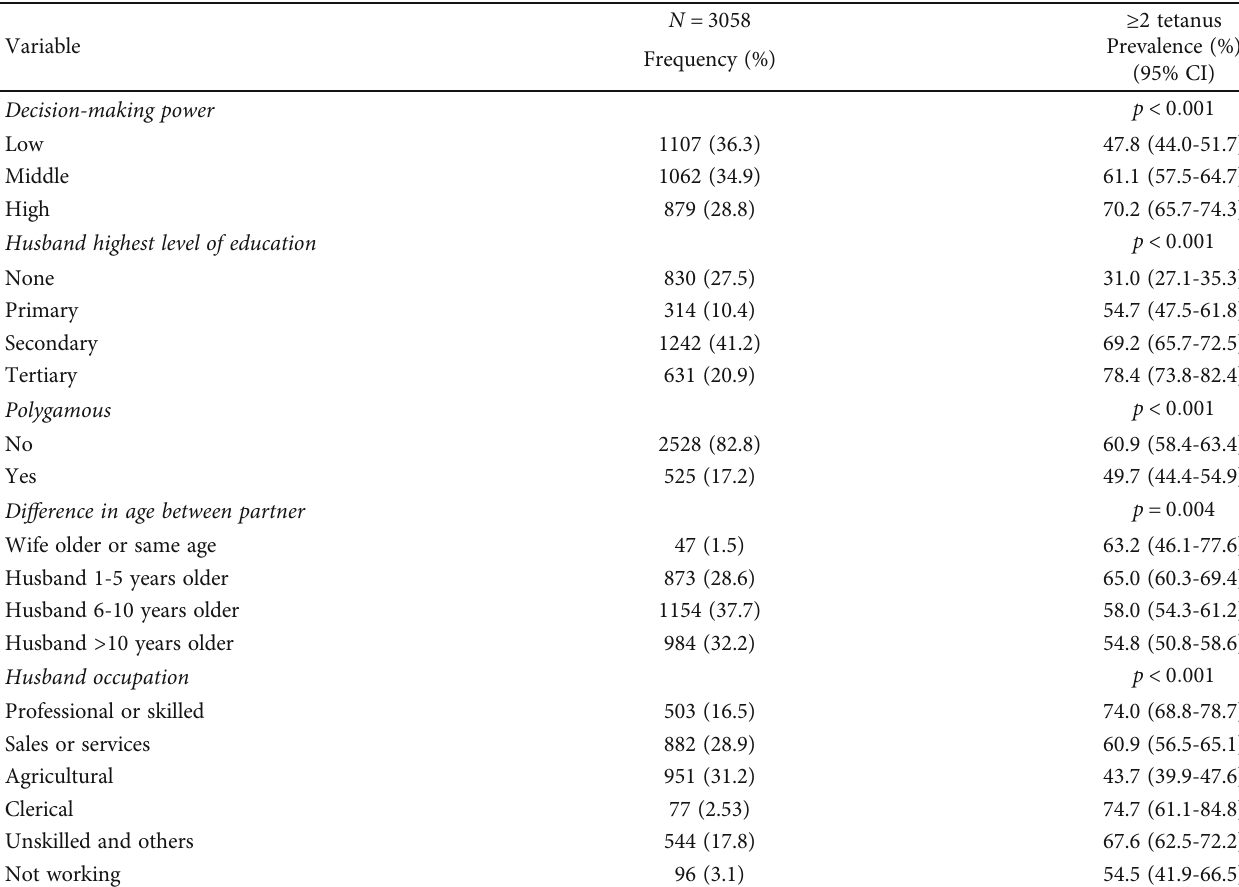
Table 2: Marriage characteristics of currently married fi rst-time mothers who took at least two doses of TTCV, NDHS 2018.